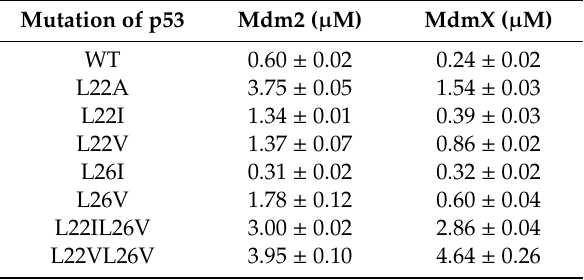
Table 1. Dissociation equilibrium constants of p53-wt and p53 mutants with Mdm2 and MdmX determined using ITC. Fitted curves are shown in Supplementary Figures S2–S8.